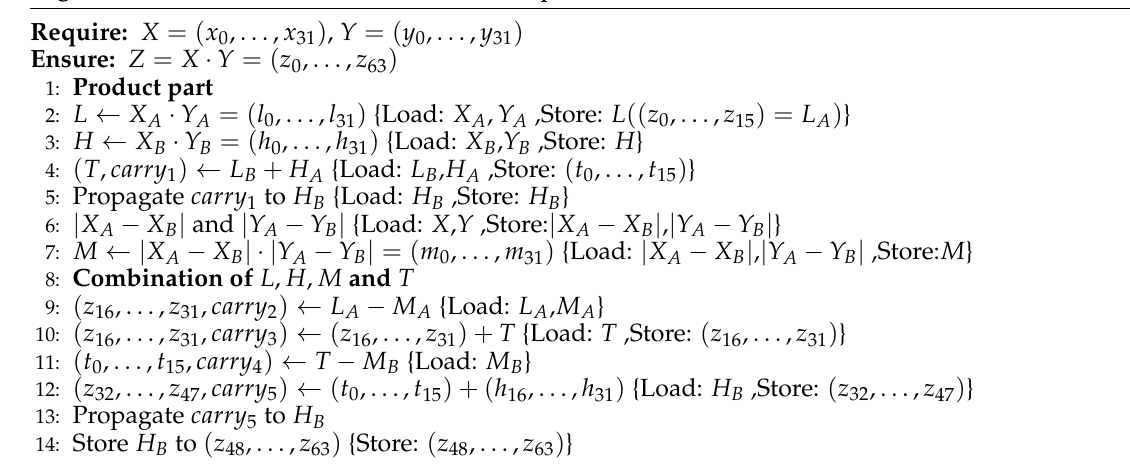
Algorithm 2 256-bit × 256-bit Karatsuba multiplication in